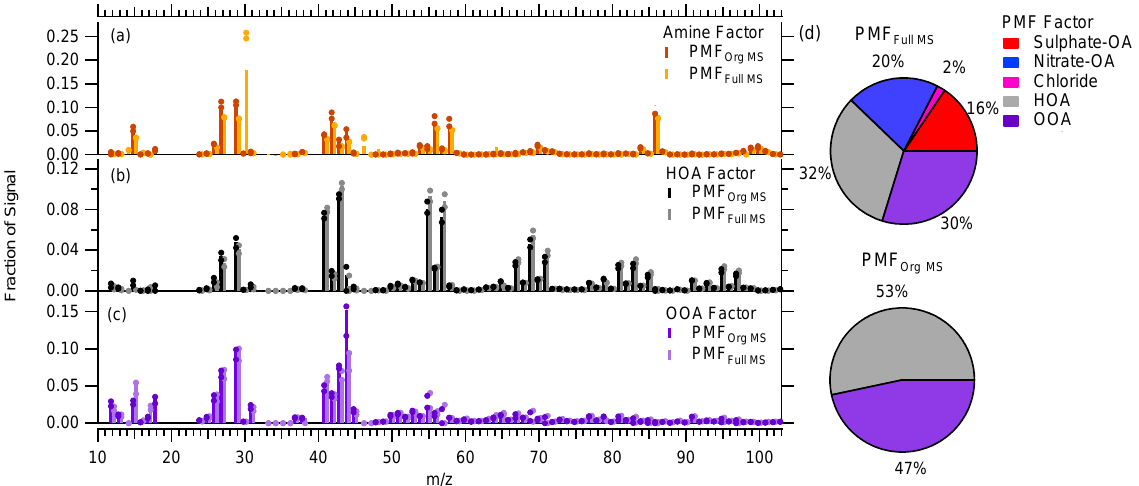
Figure 12. Comparison of factor profiles from the PMF Org MS analysis with comparable factors found by PMF of the full mass spectra (a, b, c) . The factors are normalized to the total organic fraction signal, except for the Amine factor, which is normalized to the total factor signal. Only minor differences in mass spectra are noted for the HOA factor. The most significant difference for the Amine factor is represented by the addition of the m/z 30 peak, and for the OOA factor by the difference in the magnitude of the m/z 44 peak. Dots show the range in mass spectral variation from FPeak rotations ( − 10 and 10). Also shown in (d) is the average factor composition of organics for both the PMF of the full mass spectrum and the organics